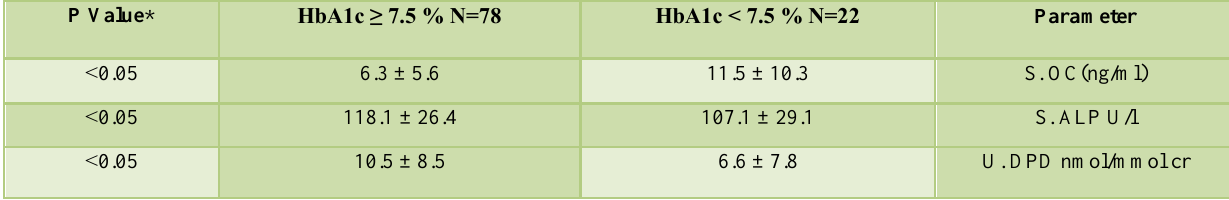
Table (1.2): The distribution of bone turnover markers among diabetic patients according to glycemic control (HbA1c %).